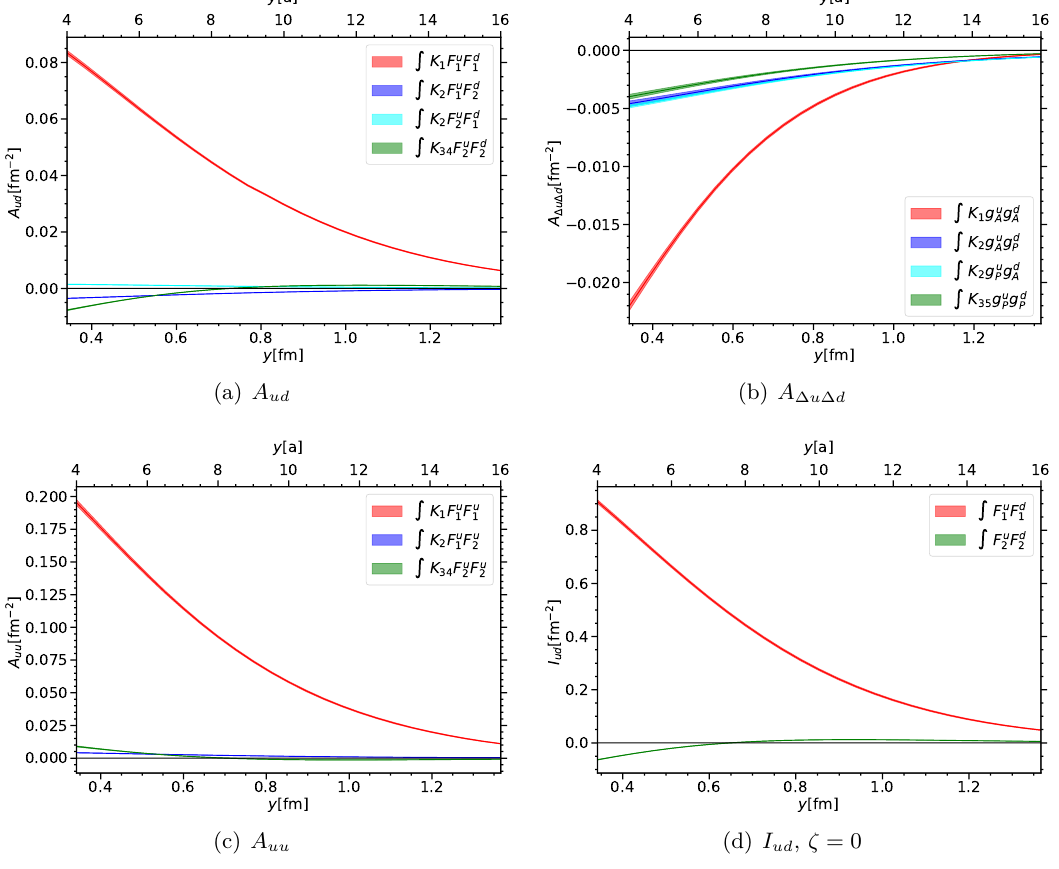
Figure 26 . Comparison between the different terms contributing to the factorized expressions for the twist-two functions A keys we use the short notation K